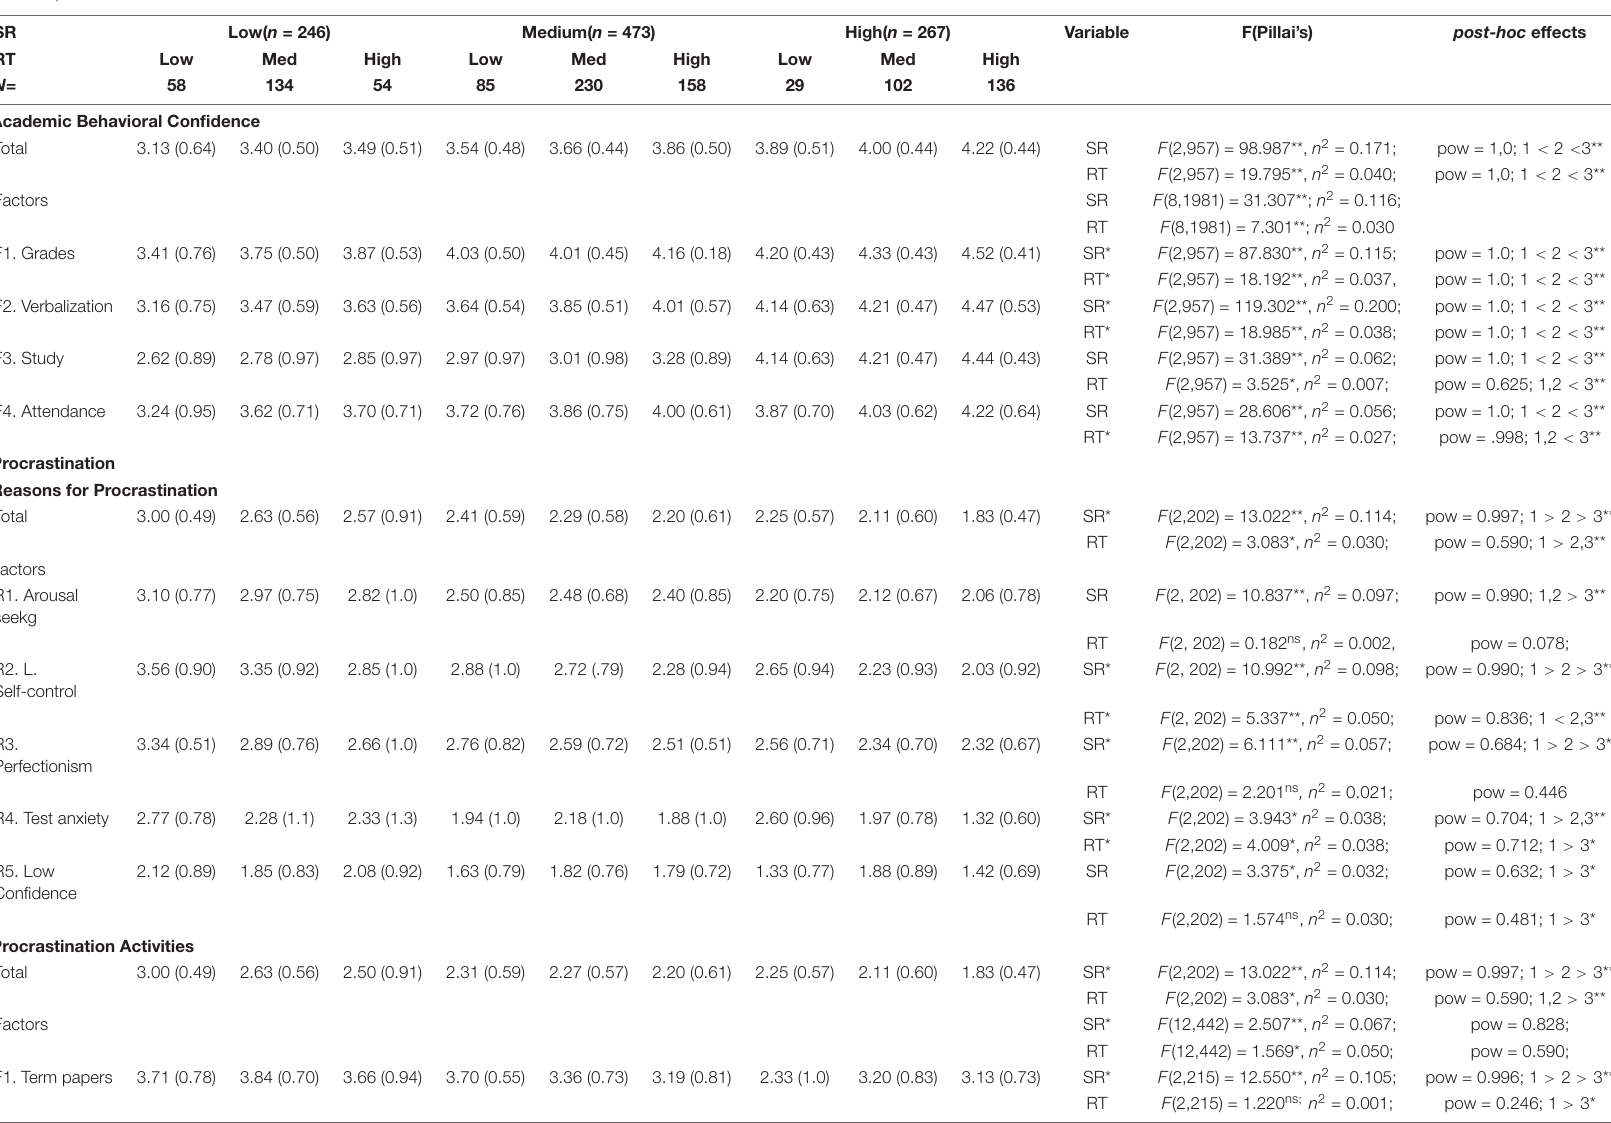
TABLE 2 | Interdependent complex effects (3 × 3) of low-medium-high levels of Self-Regulation (SR) and low-medium-high levels of Regulatory Teaching (RT) with academic behavioral confidence and procrastination ( n = 986).